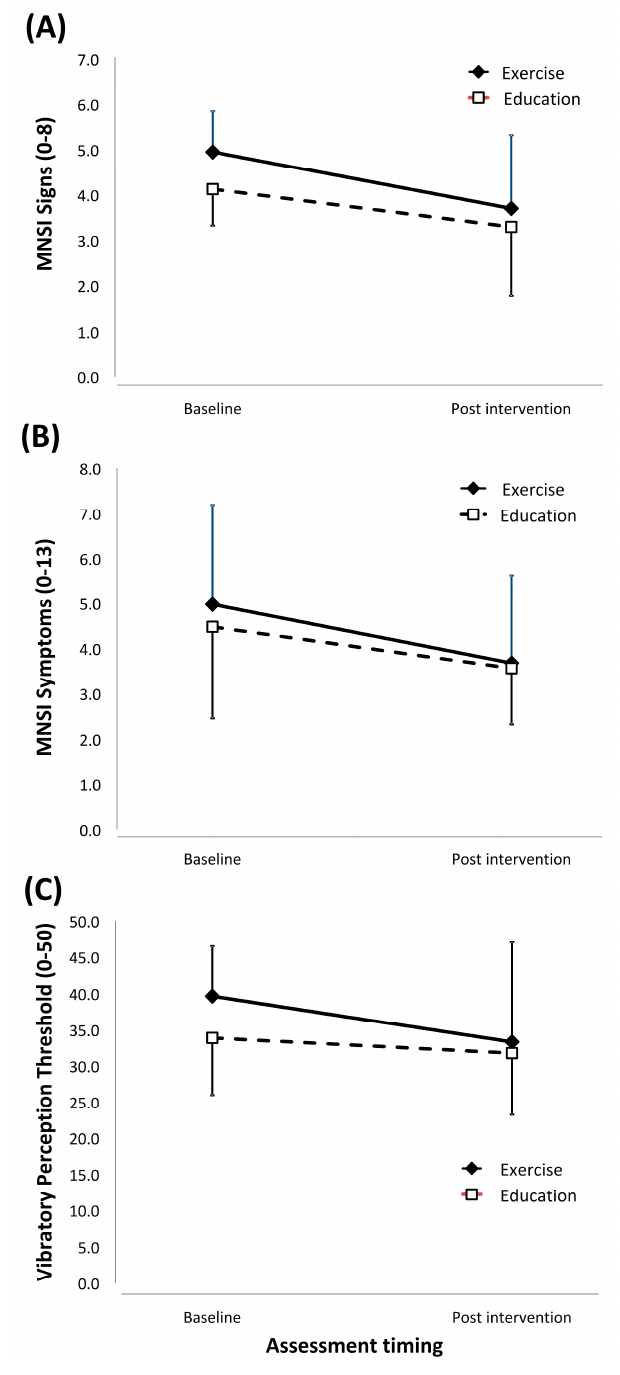
Figure 2. Graphical representation of change in primary outcome mean and standard deviation from baseline measurement to post-intervention measurement. ( A : MNSI Signs, B : MNSI Symptoms, C : Vibratory Perception Threshold).